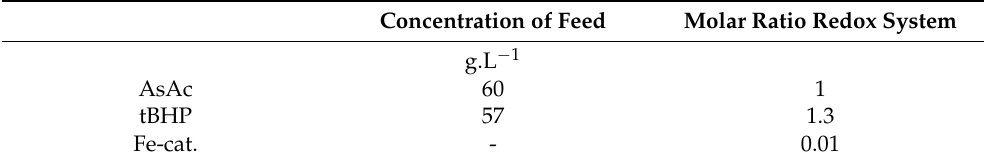
Table 5. Composition of the redox system: concentration of the redox feed and overall ratio of oxidising and reducing agent to the